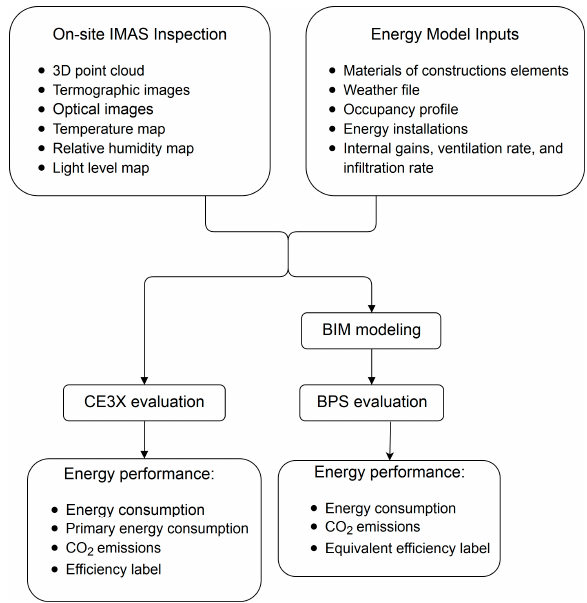
Figure 2. Methodology flow chart: from on-site data acquisition to evaluation of energy performance.